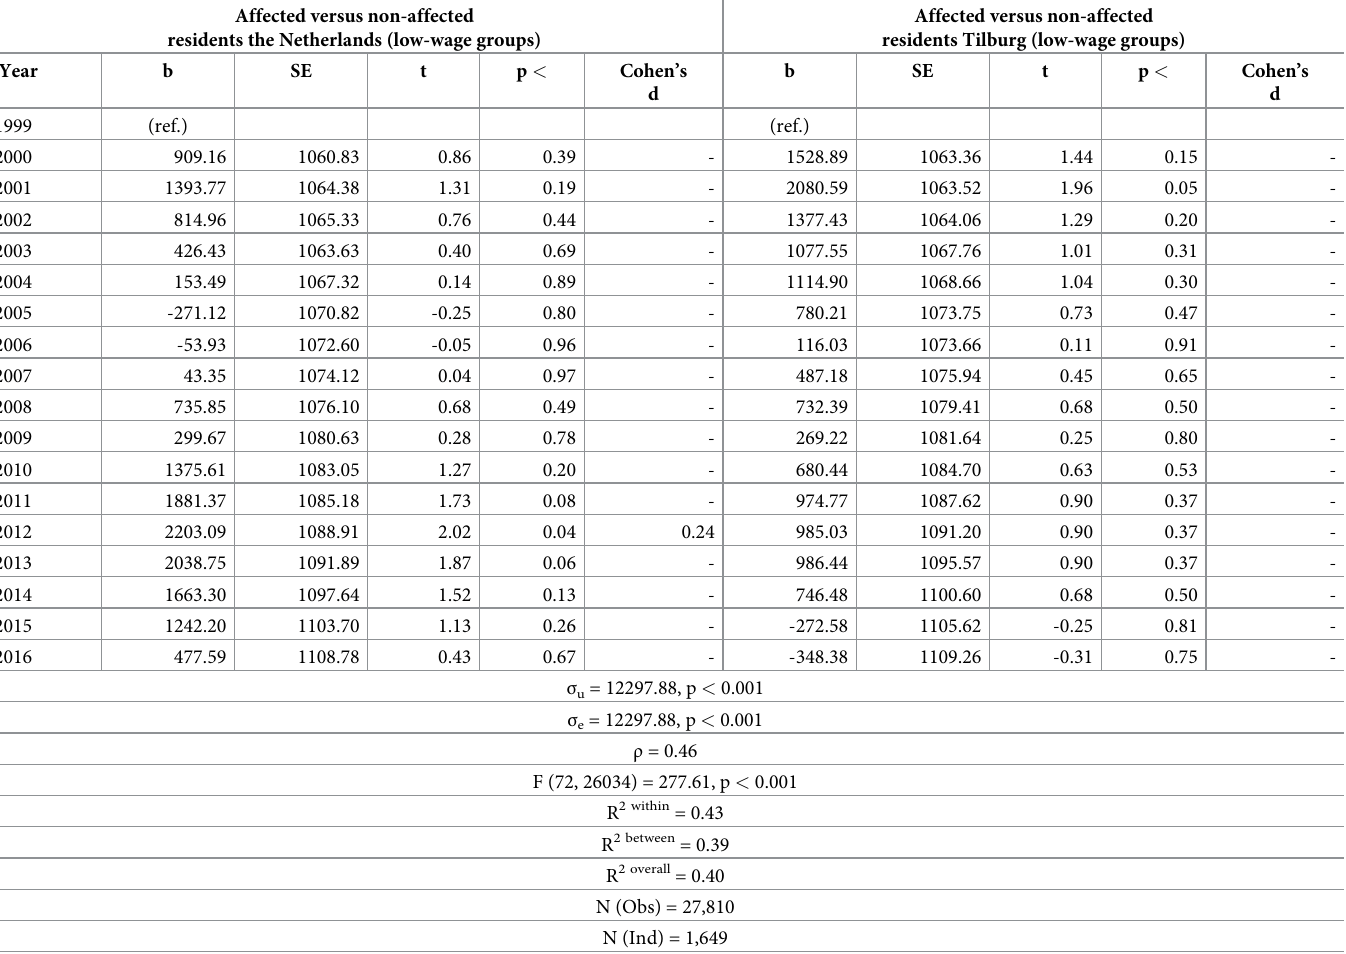
Table 3. Results of fixed-effects linear panel regression models for low-wage groups, with gross annual wages as dependent variable (1999–2016). Affected versus non-affected residents the Netherlands (low-wage groups)